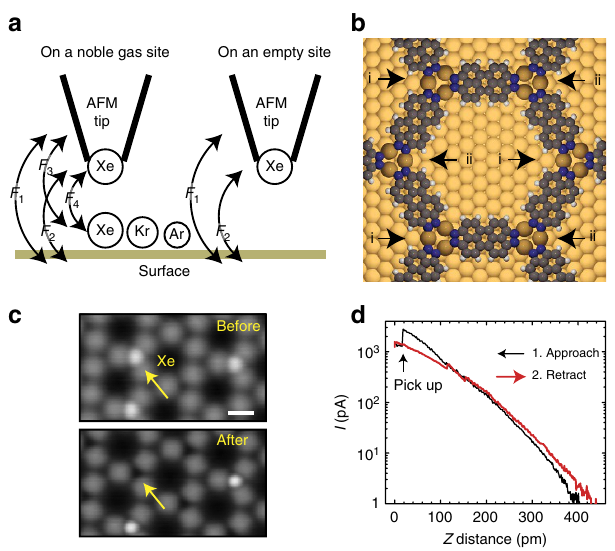
Figure 1 | Rare gas atom stabilized by 2D MOF. ( a ) Schematic drawing of the AFM measurement set-up. ( b ) Chemical structure of Cu-coordinated molecular network on Cu(111); the two symmetry-inequivalent nodal sites are indicated as i and ii. ( c ) STM topographies before and after the vertical manipulation of a Xe atom. ( d ) Distance-dependent curve of the tunnelling current in the process. Measurement parameters: I ¼ 2pA and V ¼ 200mV in c , and V ¼ 2mV in d . Scale bar, 1nm. NATURE COMMUNICATIONS|7:11559|DOI: